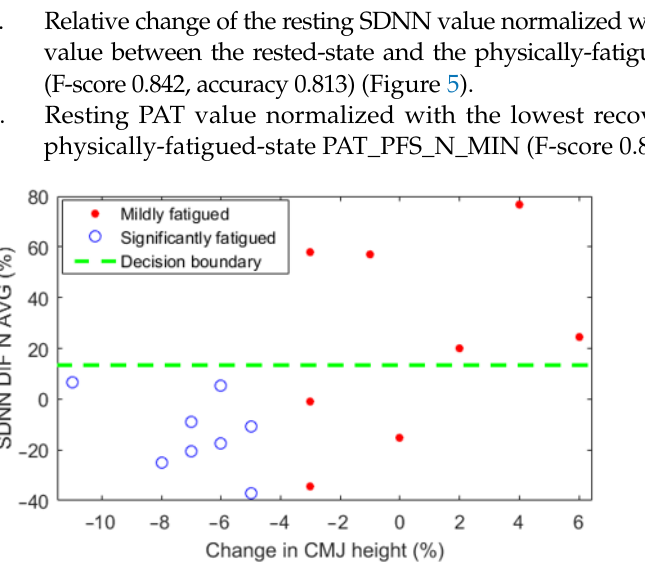
Figure 5. Change in CMJ height value compared to SDNN_DIF_N_AVG value. The subjects were arranged into the mildly fatigued and significantly fatigued groups. The shown threshold is found based on the data from all the subjects.